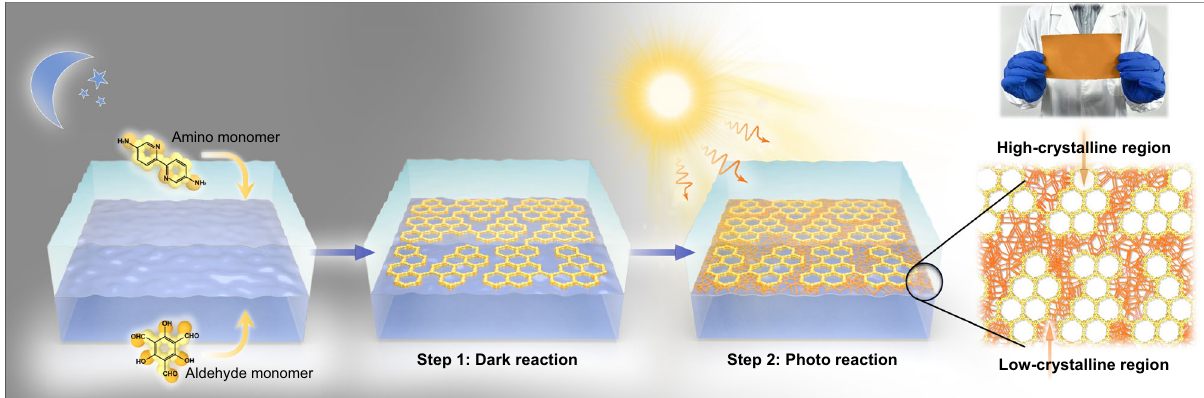
Fig. 1 Schematic preparation of heterocrystalline COM. Preparation of heterocrystalline COM by subsequent dark reaction and photo reaction using interfacial polymerization, where the top light-blue layer is the aqueous phase and the bottom navy-blue layer is the organic phase. 1,3,5- triformylphloroglucinol (Tp) and 2,2 ′ -bipyridine-5,5 ′ -diamine (Bpy) are used as aldehyde monomer and amino monomer, respectively, to prepare Schiff- base Tp-Bpy COM. The inset digital photograph is the photo-tailored heterocrystalline COM deposited on non-woven fabrics with the size of ~15 cm × 8 cm (Supplementary Fig. 1).